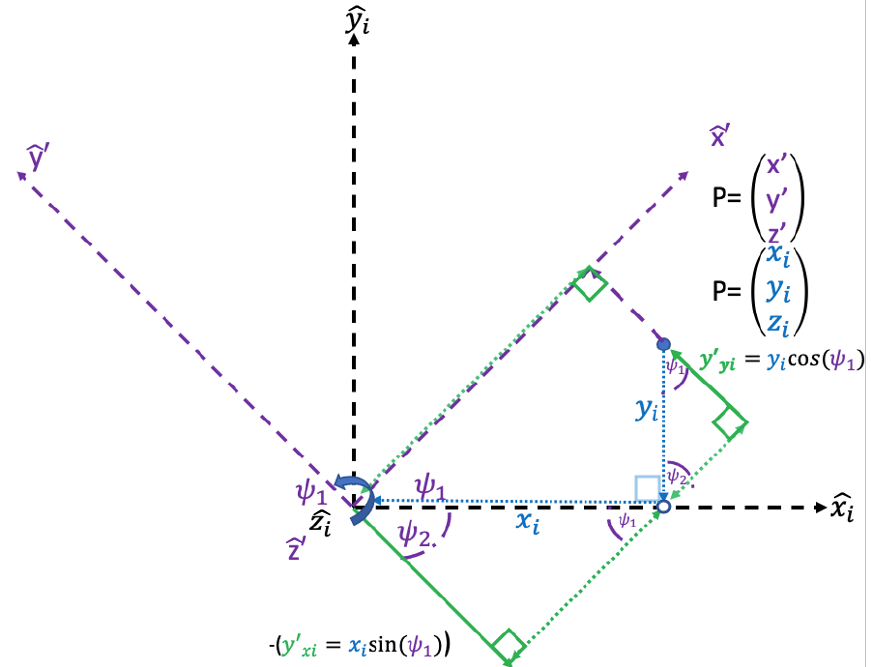
Figure 15. 3-rotation about the 𝑧 𝑖 ̂ and 𝑧′̂ axes and highlighting equations for segments 𝑦′ 𝑥𝑖 and 𝑦′ 𝑦𝑖 .